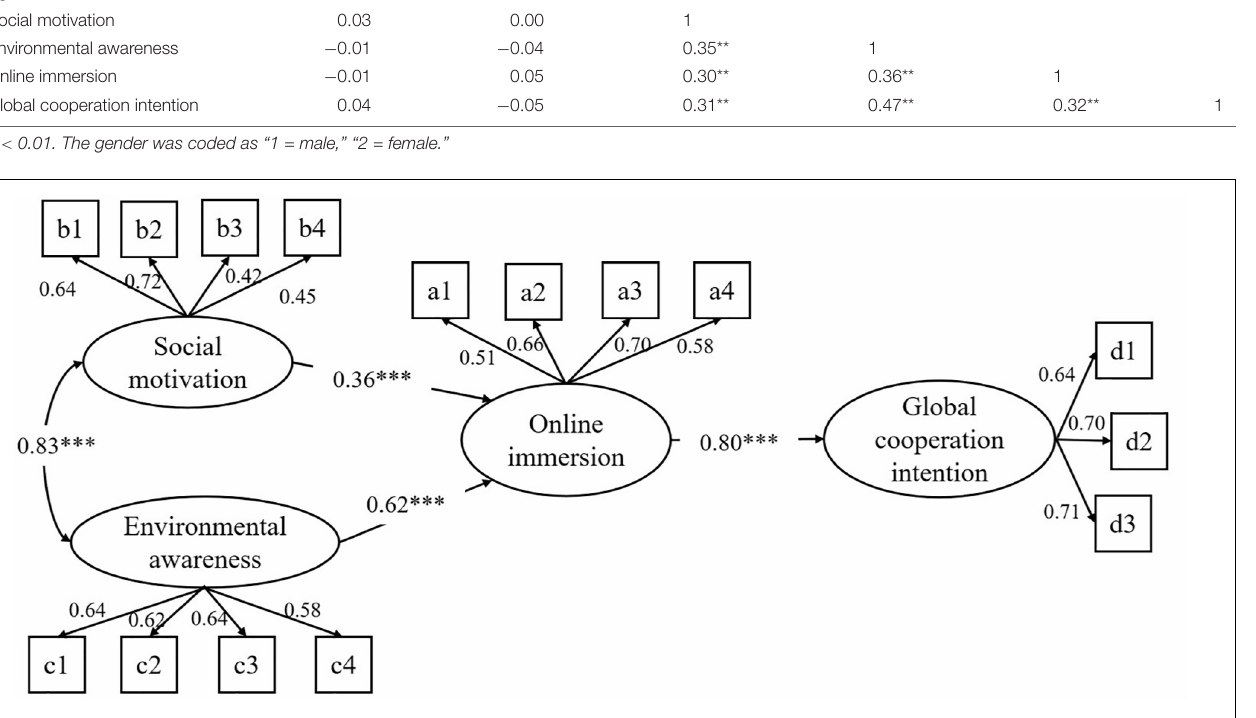
FIGURE 2 | Parameter estimation of the structural equation model. All parameter estimates are all significant at the significance level of 0.001. The results showed that social motivation and environmental awareness jointly influenced online immersion and further determined the global cooperation